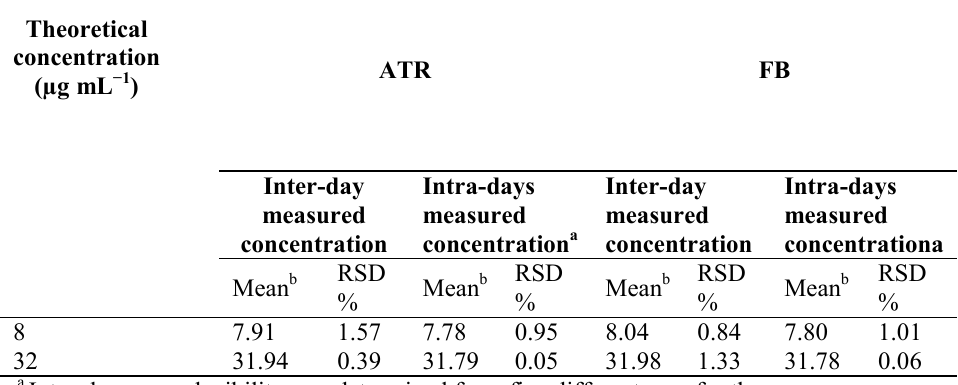
Table 3: Inter - day and Intra-days precision of ATR & FB standards.